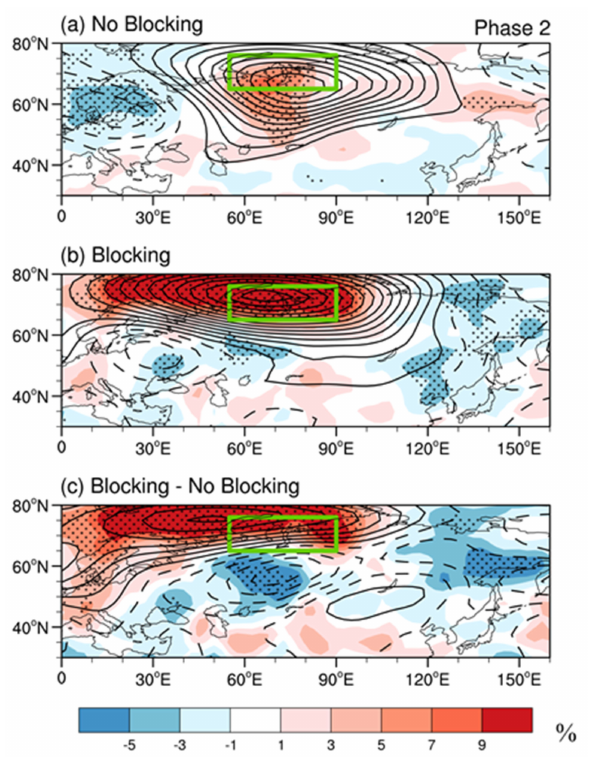
Figure 9. ( a ) Composite 10–30-day − filtered geopotential height anomaly at 500 hPa (contour interval: 8 gpm; zero line omitted) and the extreme hot events frequency anomaly (shading; unit:%) with no Ural blocking occurring; the green boxed area represents the key area of Ural blocking; ( b ) as in ( a ), but for the situation with blocking occurring; ( c ) the difference between ( b ) and ( a ); solid contours are positive values, and dashed are negative; dotted area indicating the anomalies exceeding